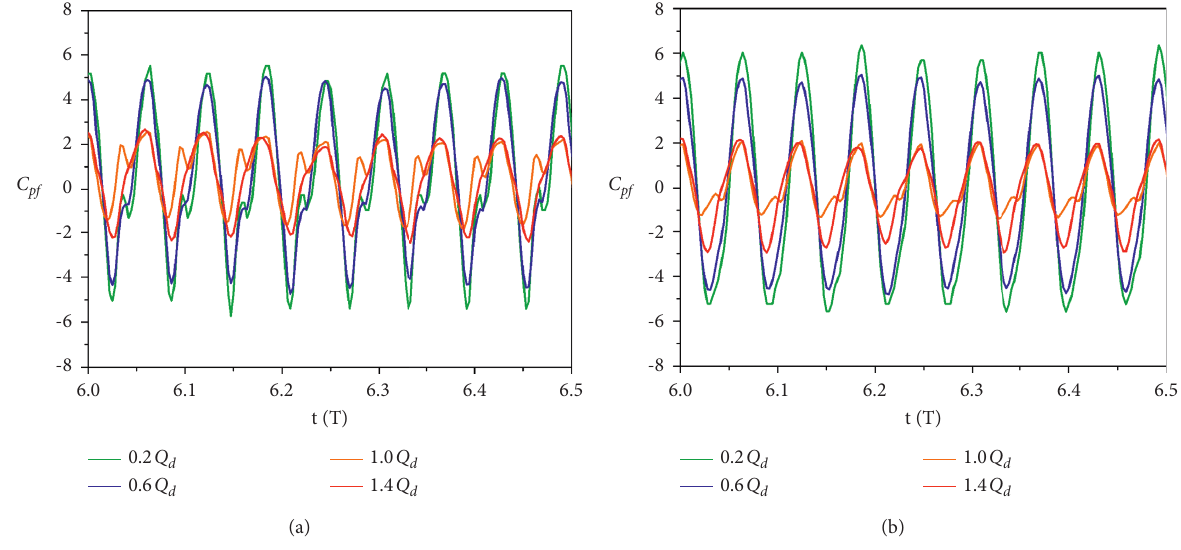
Figure 6: Time-domain pressure signals of the tongue area with different flow rates for monitors: (a) 3 and (b) 4. Table 2: Amplitude of pressure fluctuation of points at the volute.